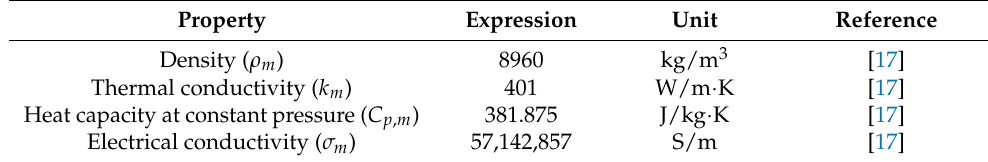
Table 2. The basic properties of electrode materials.